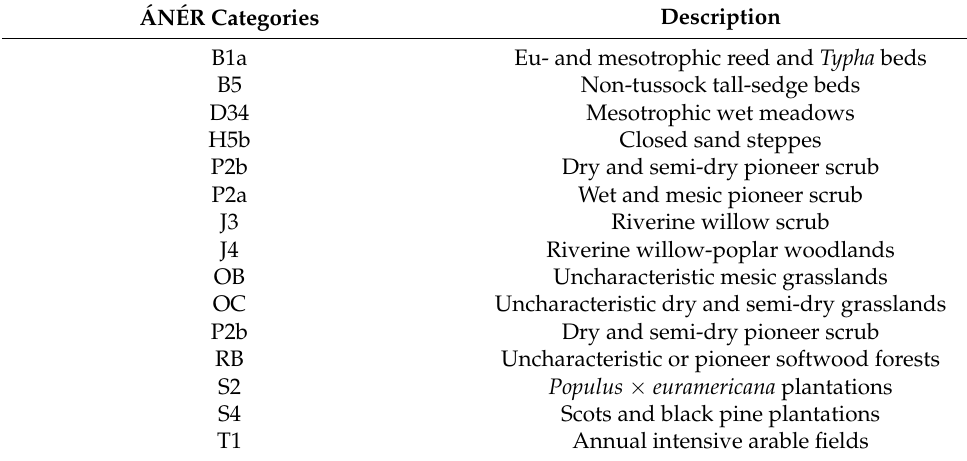
Table 1. Habitats revealed in the study area, using the categories of the Hungarian Habitat Classifica- tion System ( Á N É